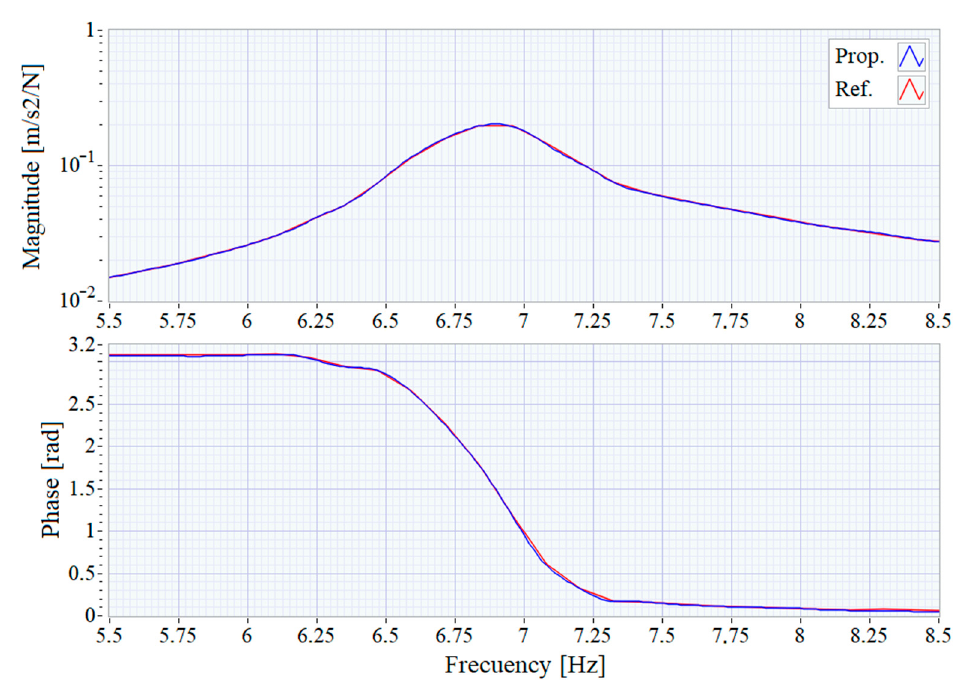
Figure 11. Frequency Response Function centered at the main resonance.